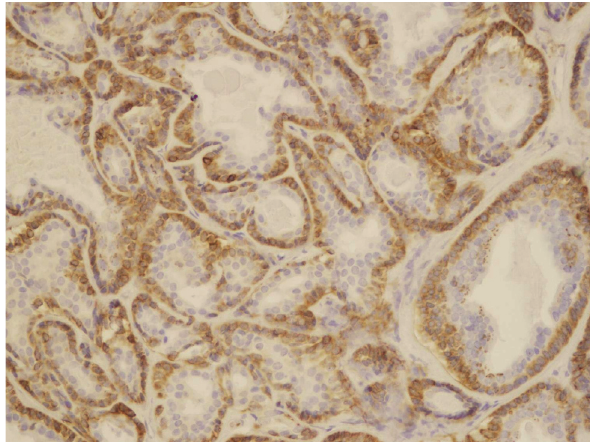
Fig. 1. Bcl-2 in the outer cells of excretory-duct like structures. Strong bcl-2 positivity in the outer cells of excretory-duct like structures. Original magnification, x 200.